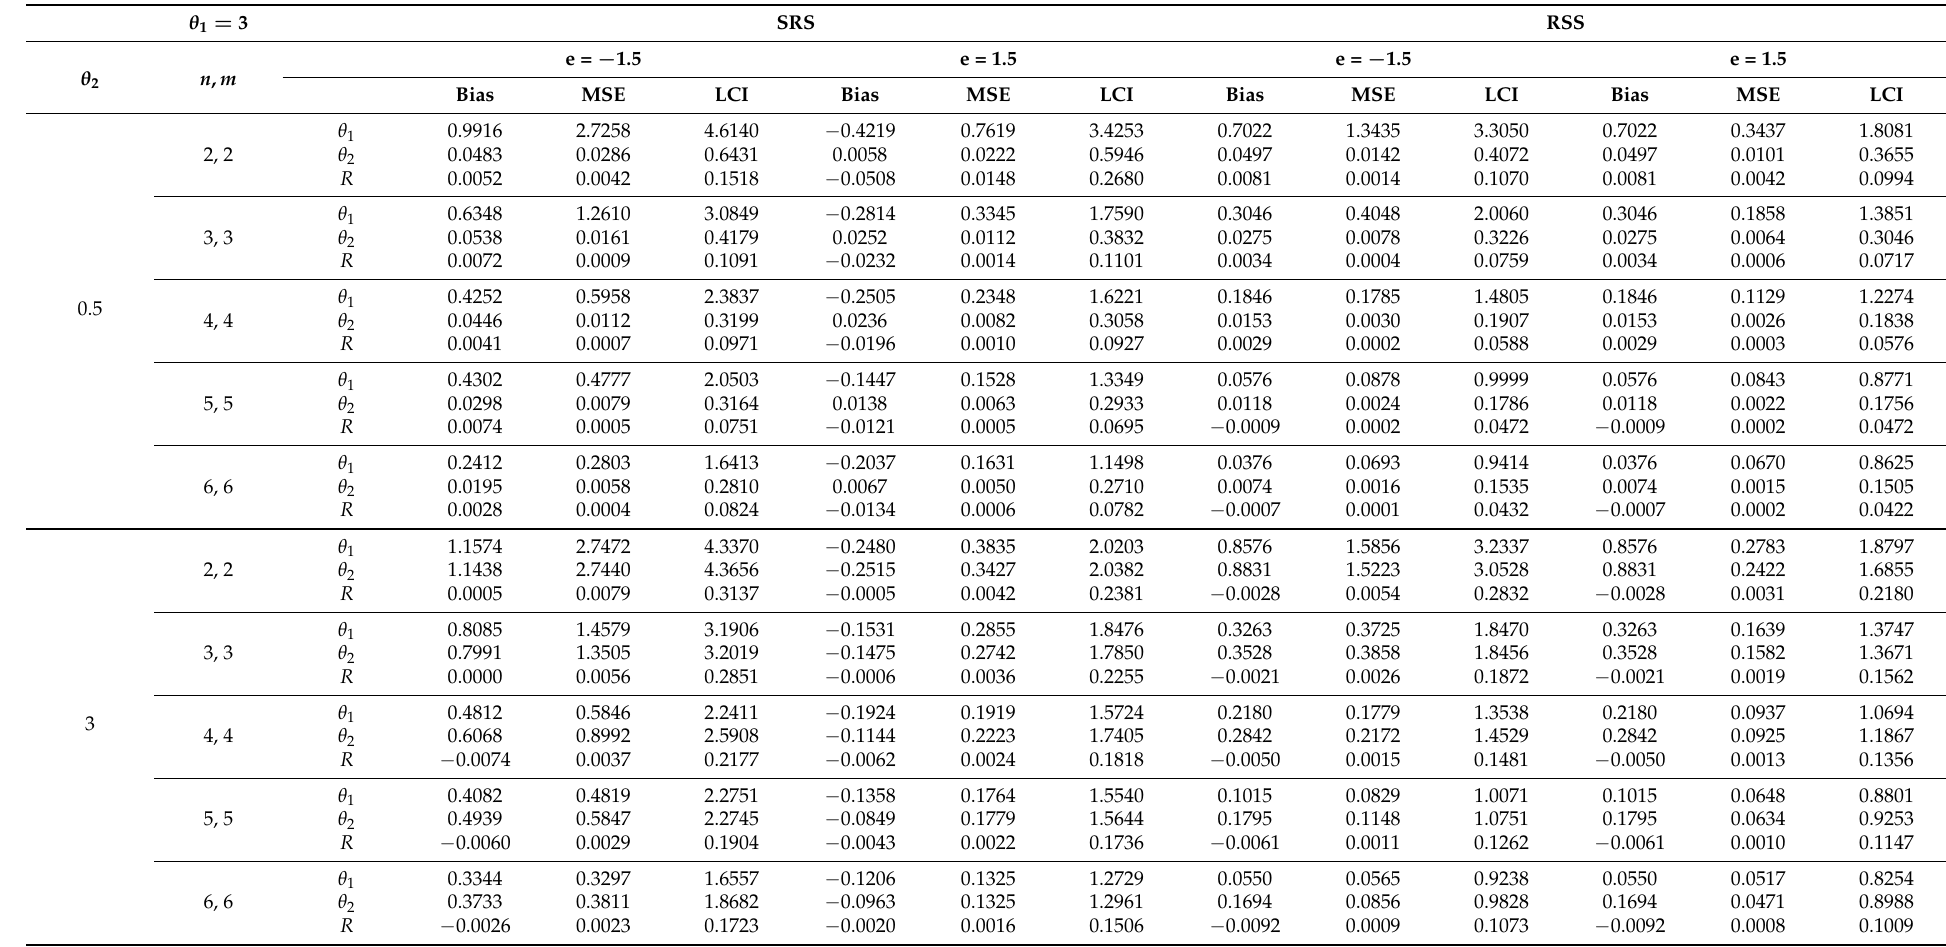
Table 7. SRS and RSS by Bayesian Method with NIP under LINEX Loss Function of Parameters and R of ITL Stress Strength Model θ 1 =